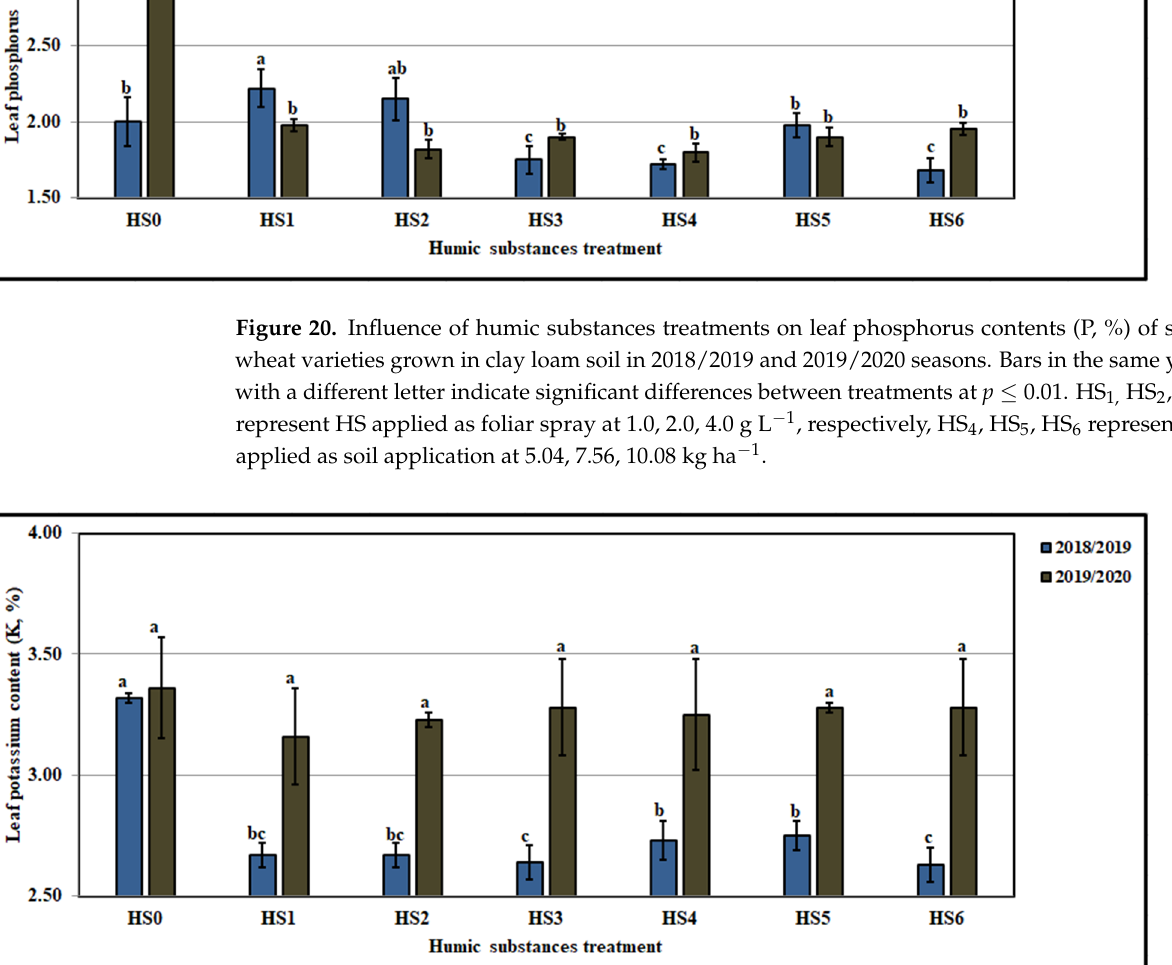
Figure 21. Influence of humic substances treatments on leaf potassium contents (K, %) of some wheat varieties grown in clay loam soil in 2018/2019 and 2019/2020 seasons. Bars in the same years with a different letter indicate significant differences between treatments at p ≤ 0.01. HS 1, HS 2 , HS 3 represent HS applied as foliar spray at 1.0, 2.0, 4.0 g L − 1 , respectively, HS 4 , HS 5 , HS 6 represent HS applied as soil application at 5.04, 7.56, 10.08 kg ha − 1 .